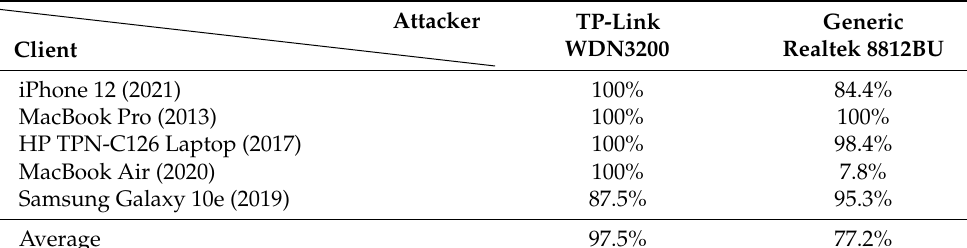
Table 4. RF device identification accuracy